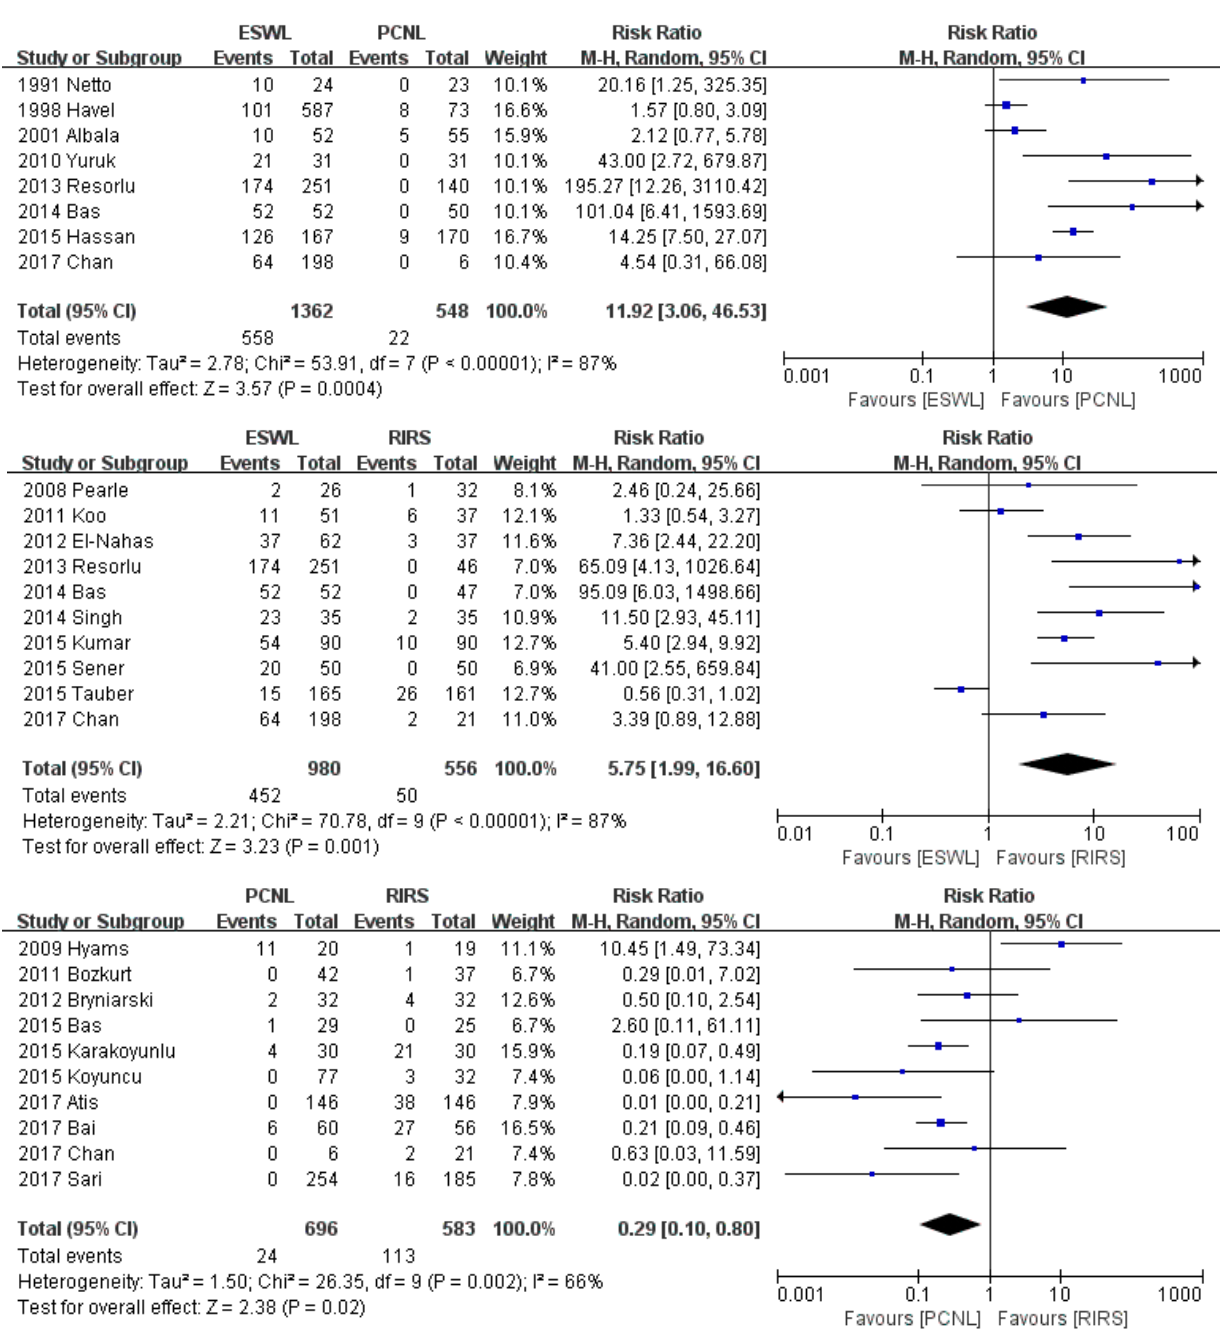
Figure 7. Meta-analysis of retreatment procedure: ( a ) ESWL vs. PCNL; ( b ) ESWL vs. RIRS; ( c ) PCNL vs. RIRS. A sub-group analysis was conducted of the criterion of 2-cm stone diameter. SFRs are compared in Figure 8. In the group of stones smaller than 2 cm, ESWL required significantly more retreatment procedures than PCNL ( p < 0.001; RR = 43.33; 95% CI, 7.45–251.91; I 2 = 39%), and RIRS ( p = 0.001; RR = 6.25; 95% CI, 2.02–19.32; I 2 = 89%), whereas there was no significant difference between PCNL and RIRS ( p = 0.46; RR = 0.44; 95% CI, 0.05–3.61; I 2 = 0%). In the group of stones larger than 2 cm, like in the primary analysis,